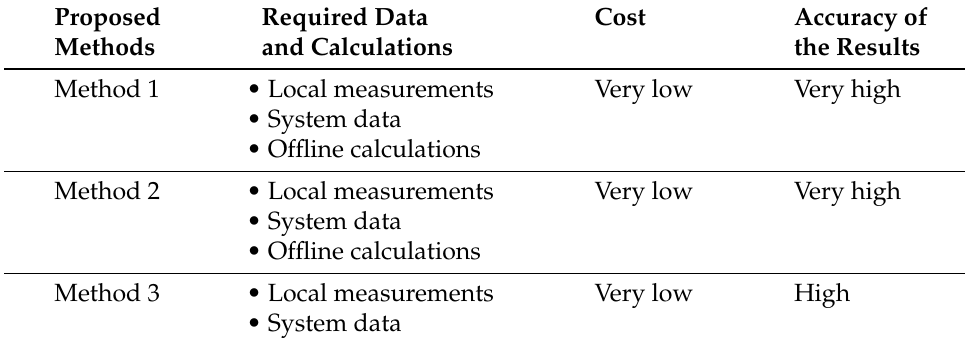
Table 2. Comparison of the proposed